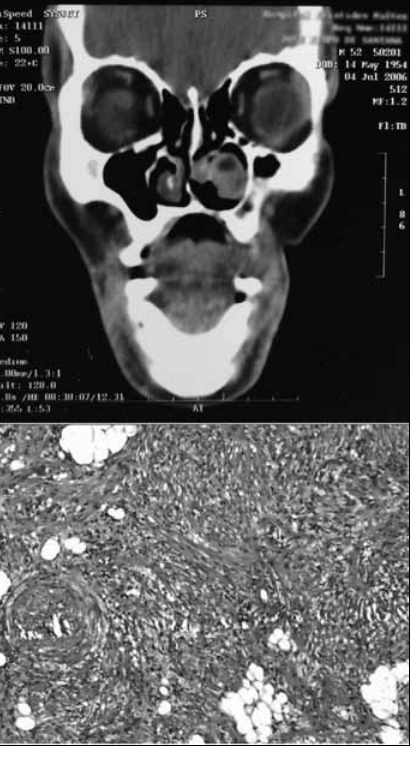
Figure 1. ABOVE: CT scan showing a tumor in the left inferior meatus, without signs of bone destruction. BELOW: Smooth muscle fibers, fat tissue without atypias and thick-wall vessels. H&E